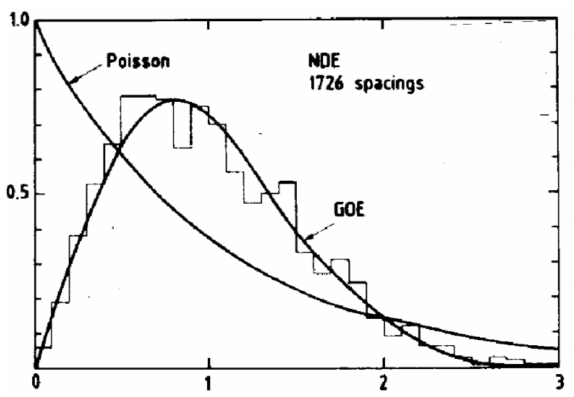
Figure 2: The nearest neighbour spacing distribution (i.e., P ( s ) ) for nuclear data. The GOE (Gaussian Orthogonal Ensemble) and Poisson are shown by solid curves. This figure is taken from - ‘Fluctuation Properties of Nuclear Energy Levels and Widths : Comparison of Theory with Experiment’ by O. Bohigas, R. U. Haq, and A.